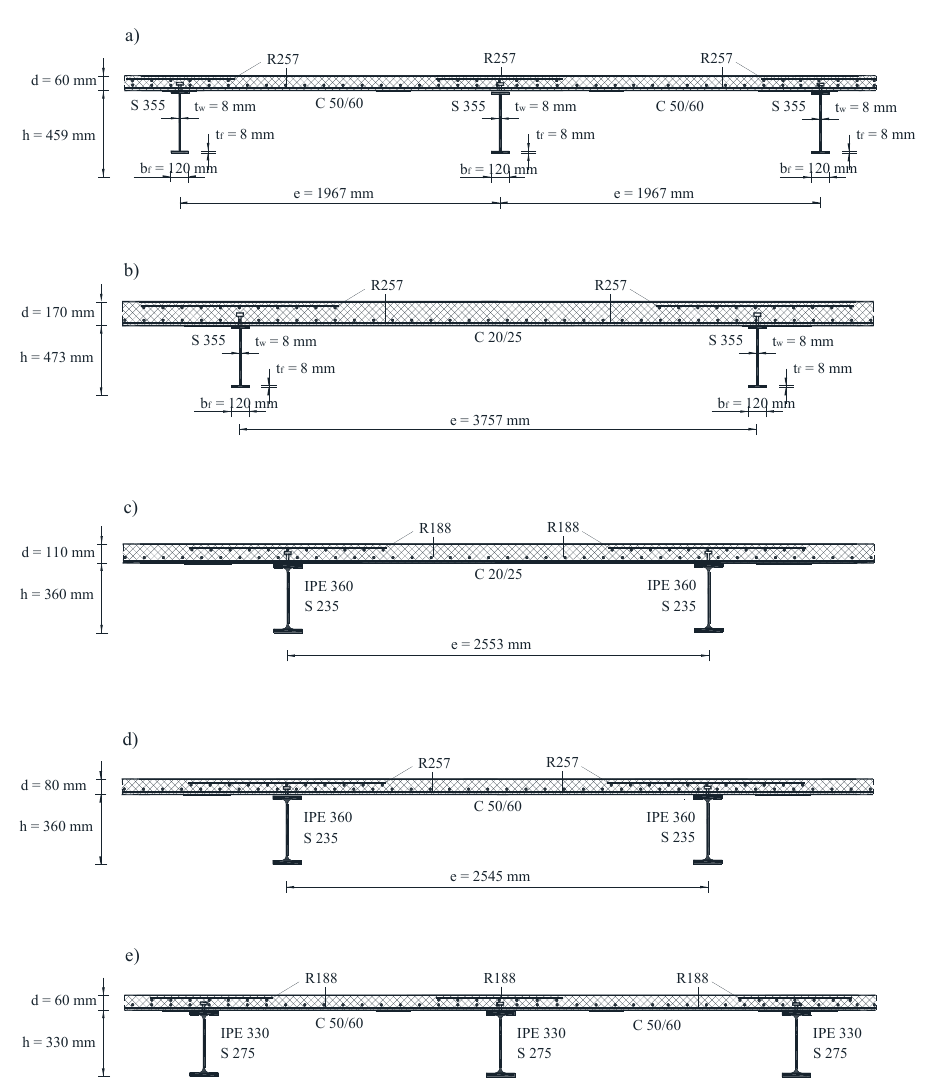
Figure 5. The optimized composite floor structures; ( a ) mass objective function; ( b ) direct cost objective function—DC; ( c ) energy life-cycle cost objective function of an energy efficient case—ELCC EEC; ( d ) energy life-cycle cost objective function of an energy inefficient case—ELCC IEC; ( e ) energy life-cycle cost objective function of a high energy consumption case—ELCC HEC.